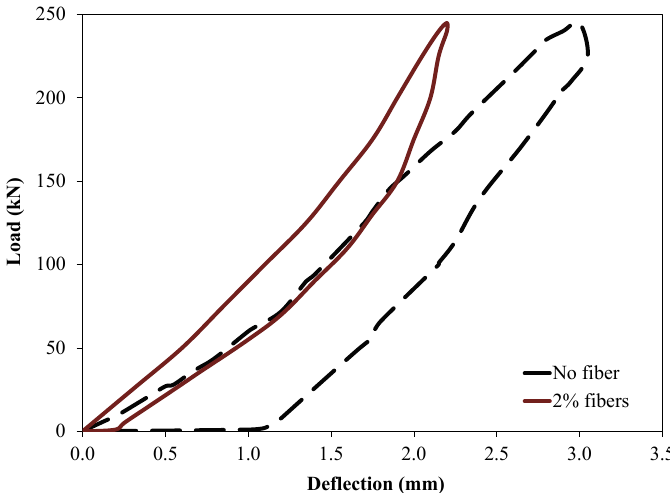
Figure 10. Thrust load test results on reduced scale PCTL segments made with UHPC.